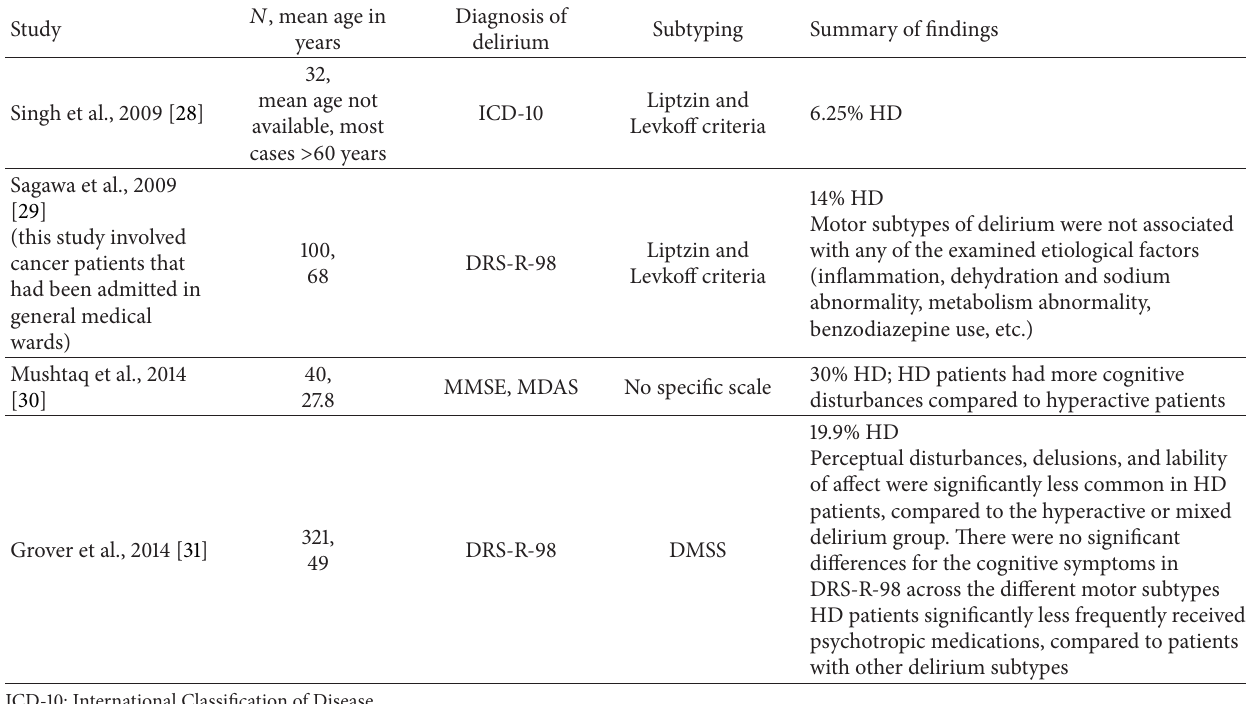
Table 2: HD in consultation-liaison